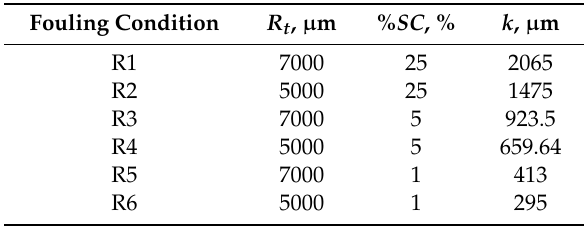
Table 1. Studied fouling